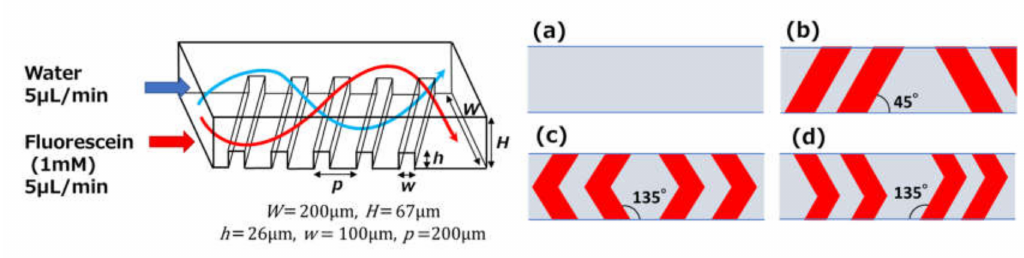
Figure 7. Schematic diagram of chaotic mixing (illustrated by the streamlines of two fluids) in a microchannel and designs of three types of chaotic mixers. The mixing e ffi ciency was estimated in ( a ) a rectangular microchannel without ridges, which was used for comparison, and ( b ) a chaotic mixer with periodic oblique, ( c ) symmetric V-shaped, and ( d ) asymmetric V-shaped ridges embedded in the